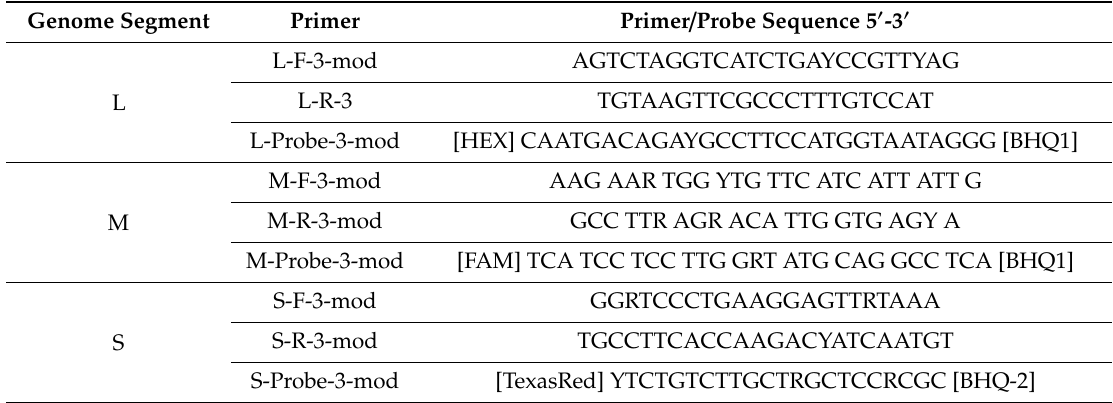
Table 2. Primer and probe sequences used in the quantitative SFTSV multiplex RT-qPCR